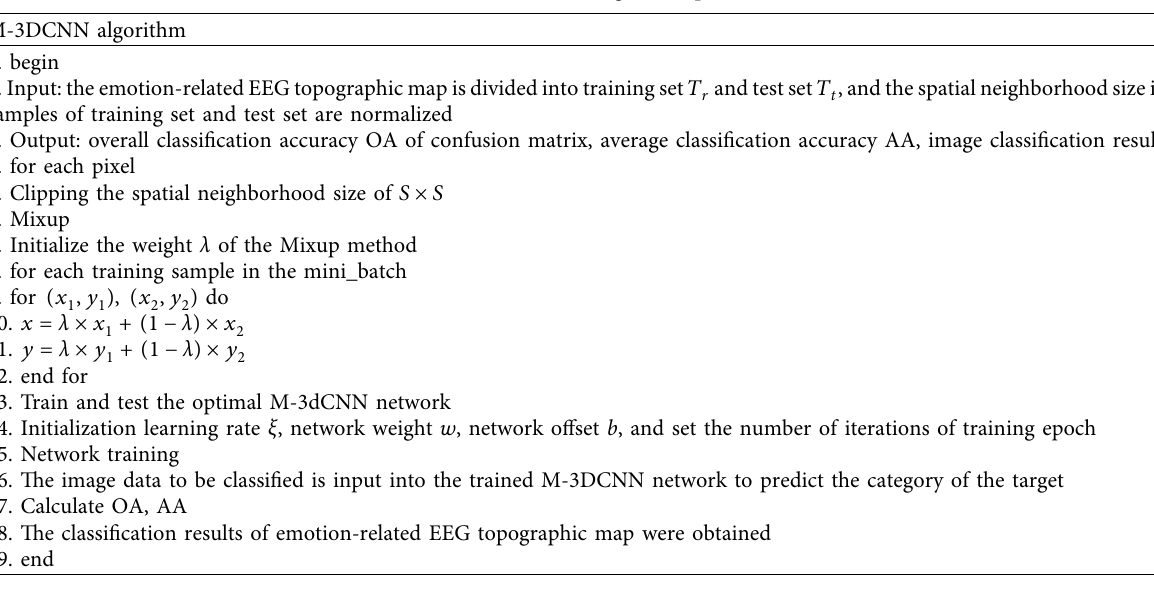
Table 2: M-3DCNN algorithm pseudocode.